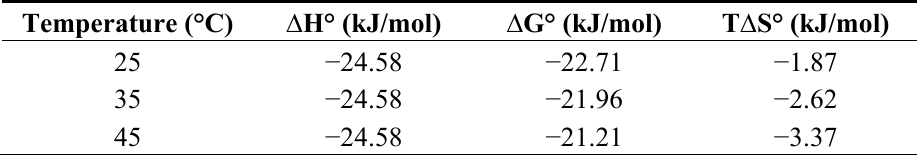
Table 5. Thermodynamic parameters for Cr(VI)